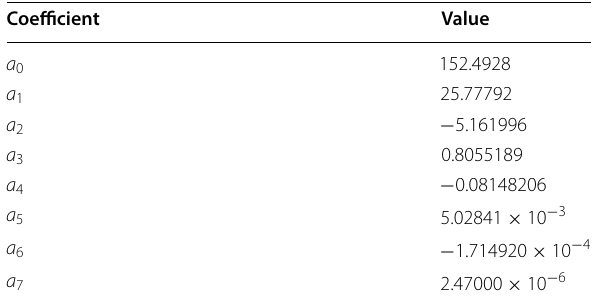
Table 1 Actual values of coefficients a i